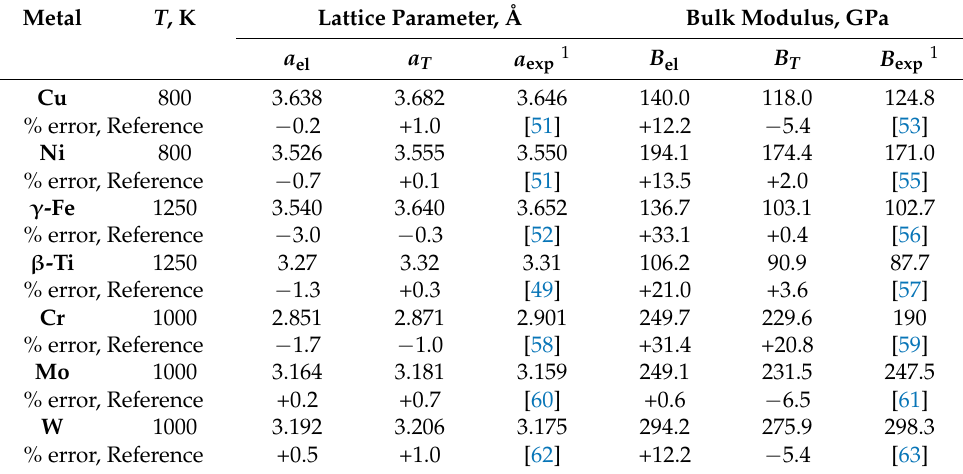
Table 1. Calculated lattice parameters and bulk moduli of selected cubic metals at elevated tempera- tures, in comparison with experimental data. “Electronic” a el and B el are determined, respectively, from the minimum and the curvature of the partial free energy curve as in Figure 1b. Equilibrium a T and B T are calculated from the minimum and the curvature of the Helmholtz free energy curve corresponding to temperature T , see Figure 1d for